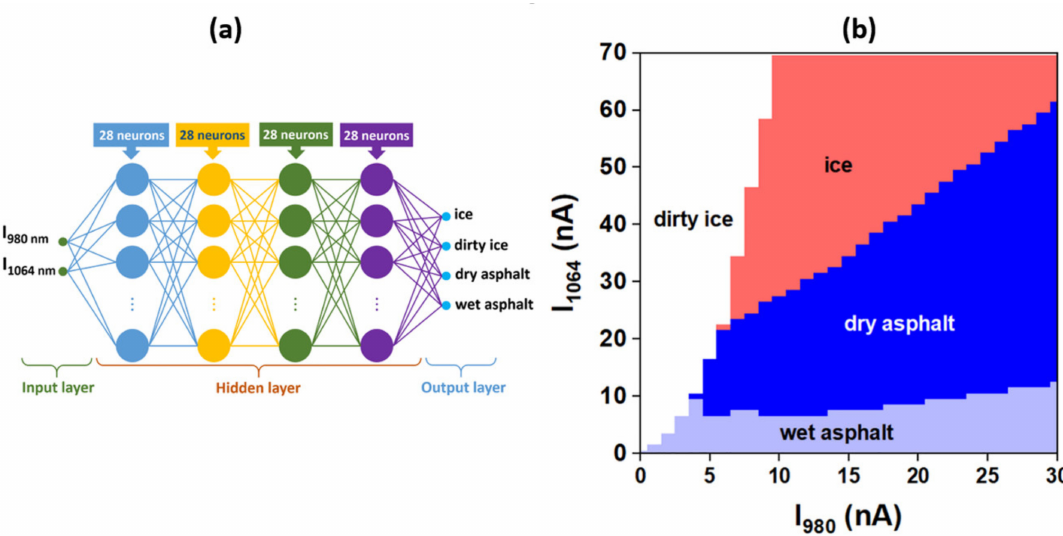
Figure 8. Artificial neural network (ANN) algorithm: ( a ) the working principle and ( b ) ANN algorithm applied to array data.